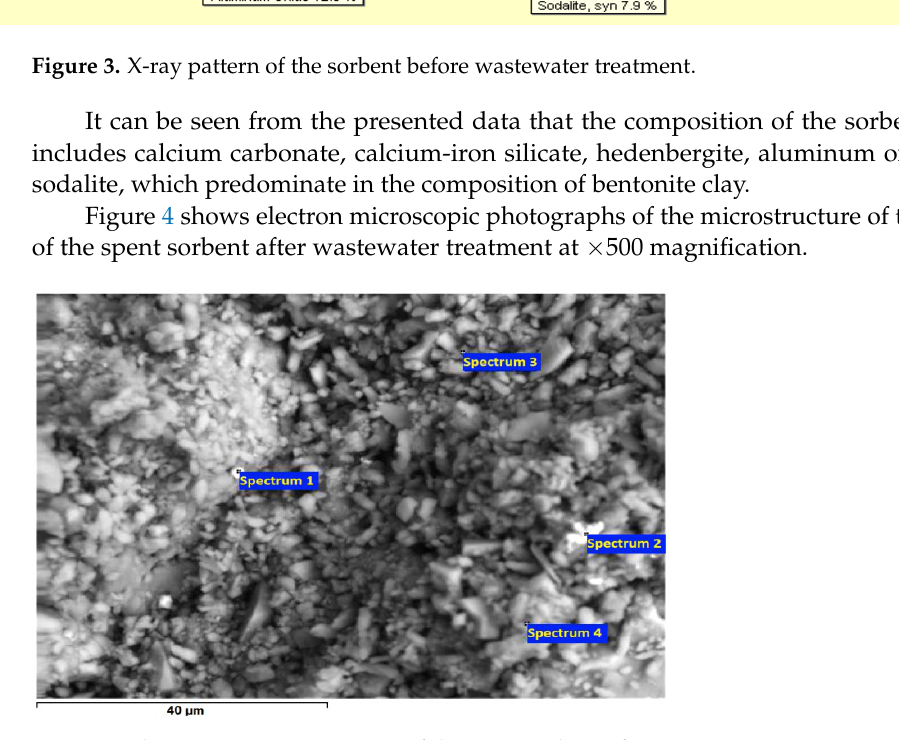
Figure 4. Electron microscopic image of the spent sorbent after wastewater treatment. An analysis of the morphology of the spent sorbent particles showed some changes in their structure. The particles significantly decreased in size. This is due to the addi- tional dispersion of clay particles during sorption. The surface structure of the sorbent also remains homogeneous and fairly dense, with uniformly distributed particles, and there are pores between the particles. Table 4 shows the composition of the spent sorbent after wastewater treatment. Table 4. Composition of the spent sorbent after wastewater treatment. Spectrum